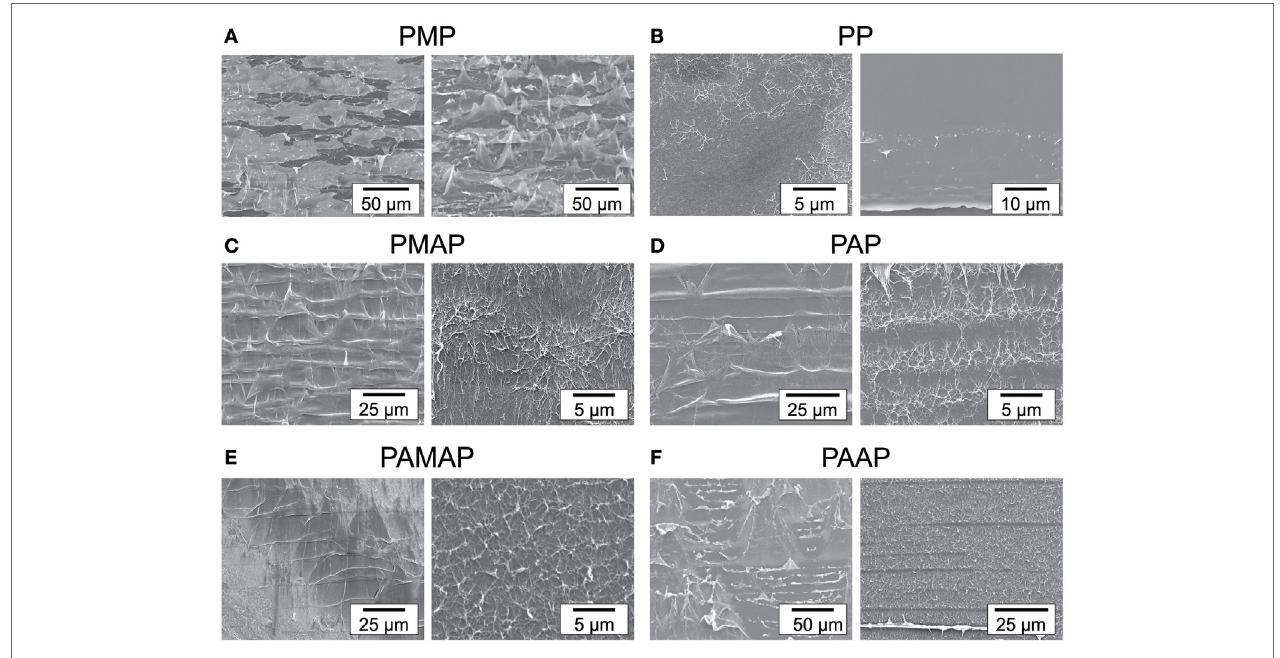
except for thin strands of Parylene on the bottom layer (left image). Devices with Al 2 O 3 with or without a layer of Pt (c–F) were similar in that the bottom layers (left images) contained parallel ridges topped with plastically deformed flaps of Parylene and the top layers (right images) contained clusters of thin strings of Parylene. Note that images are at different scales (surfaces were sputtered coated with Pt before